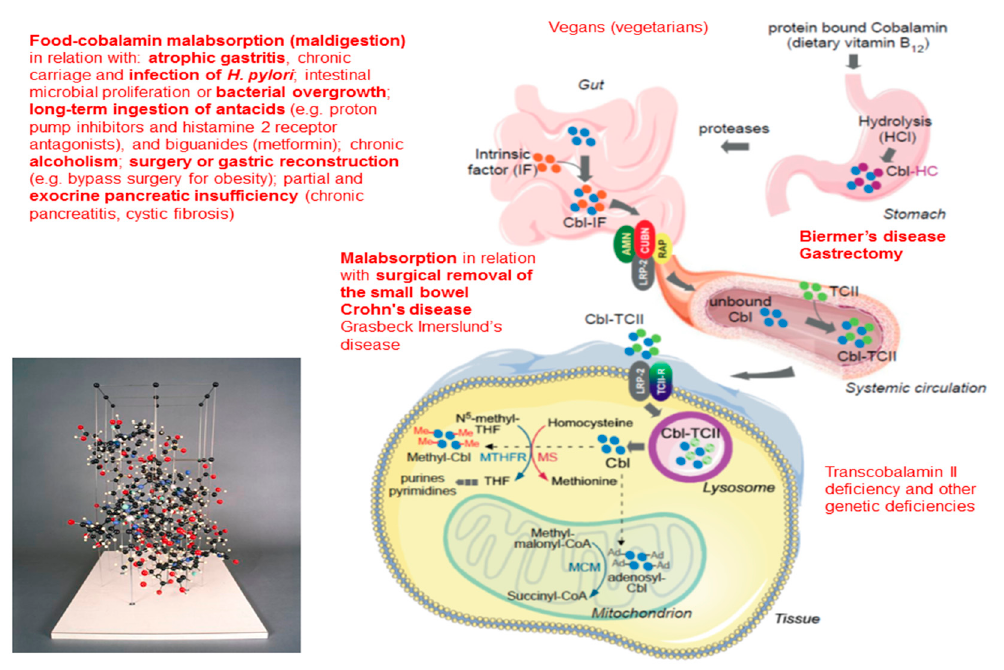
Figure 2. Structure and metabolism of the vitamin B12, with a focus on gastrointestinal disorders responsible for vitamin B12 deficiency. The digestive step of the metabolic of cobalamin (cbl) begins with nutrient intake to its intestinal absorption. Endocytic receptors and proteins responsible for vitamin B12 intestinal absorption include cubilin (CUBN), amnionless (AMN), receptor-associated protein and megalin (MGA1). The membrane megalin/transcobalamin II (TCII)-receptor complex allows the cellular uptake of cbl. Lysosomal-mediated degradation of TCII and subsequent release of free-cbl is essential for vitamin B12 metabolic functions. MS, methonine synthase; THF, tetrahydrofolate; MTHFR, methylene tetrahydrofolate reductase; MCM, methylmalonyl CoA